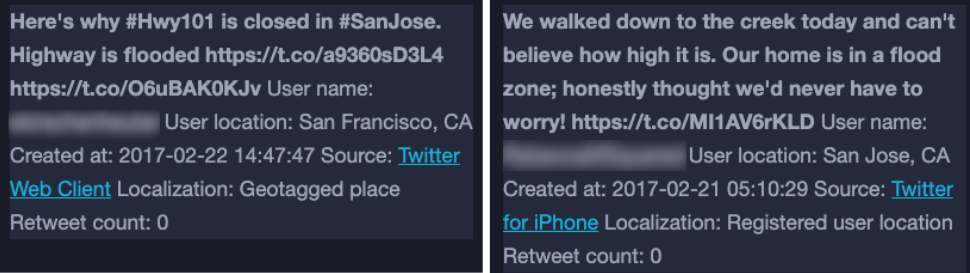
Figure 14. Example tweets revealing local aspects and